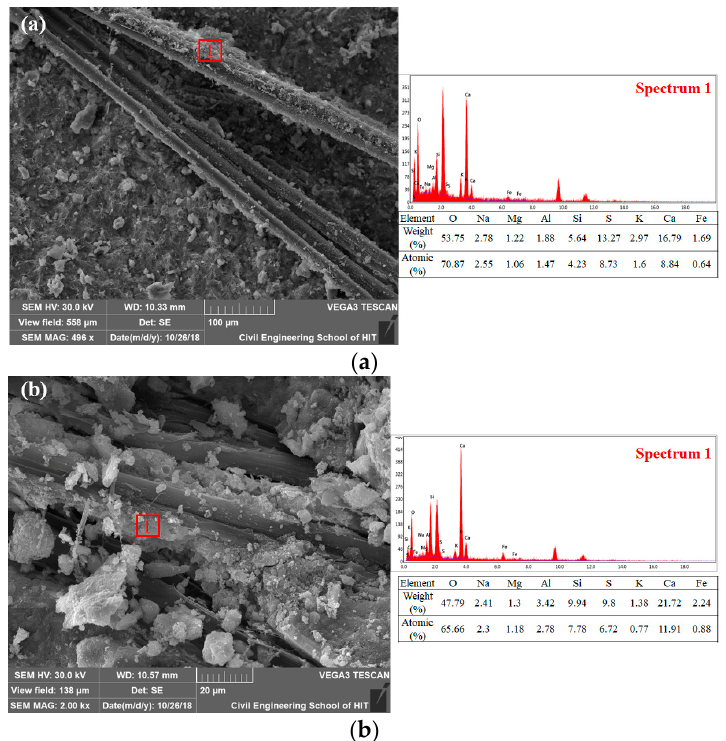
Figure 2. SEM image of cement paste with 0.5 wt %. ( a ) Original flax fiber (F0.5) and ( b ) alkali modified flax fiber (MF0.5) at 1000 × .